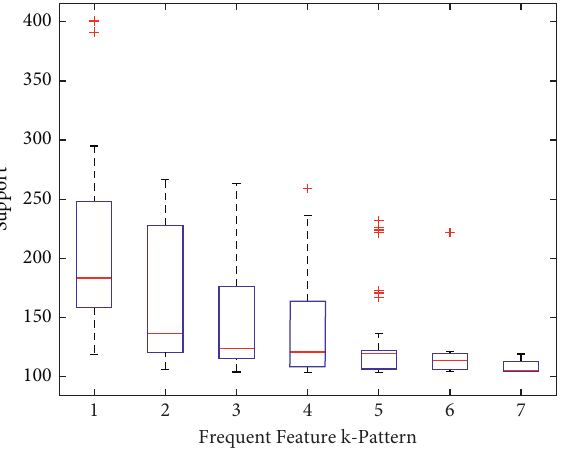
Figure 15: Support